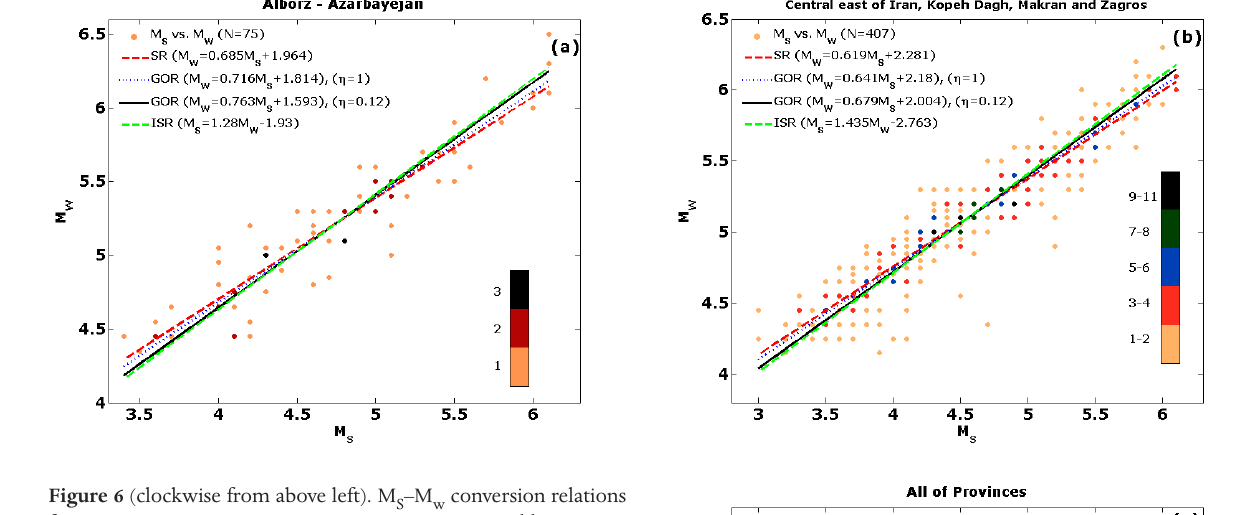
–M conversion relations S w ≤ 6.1). Abbreviations s